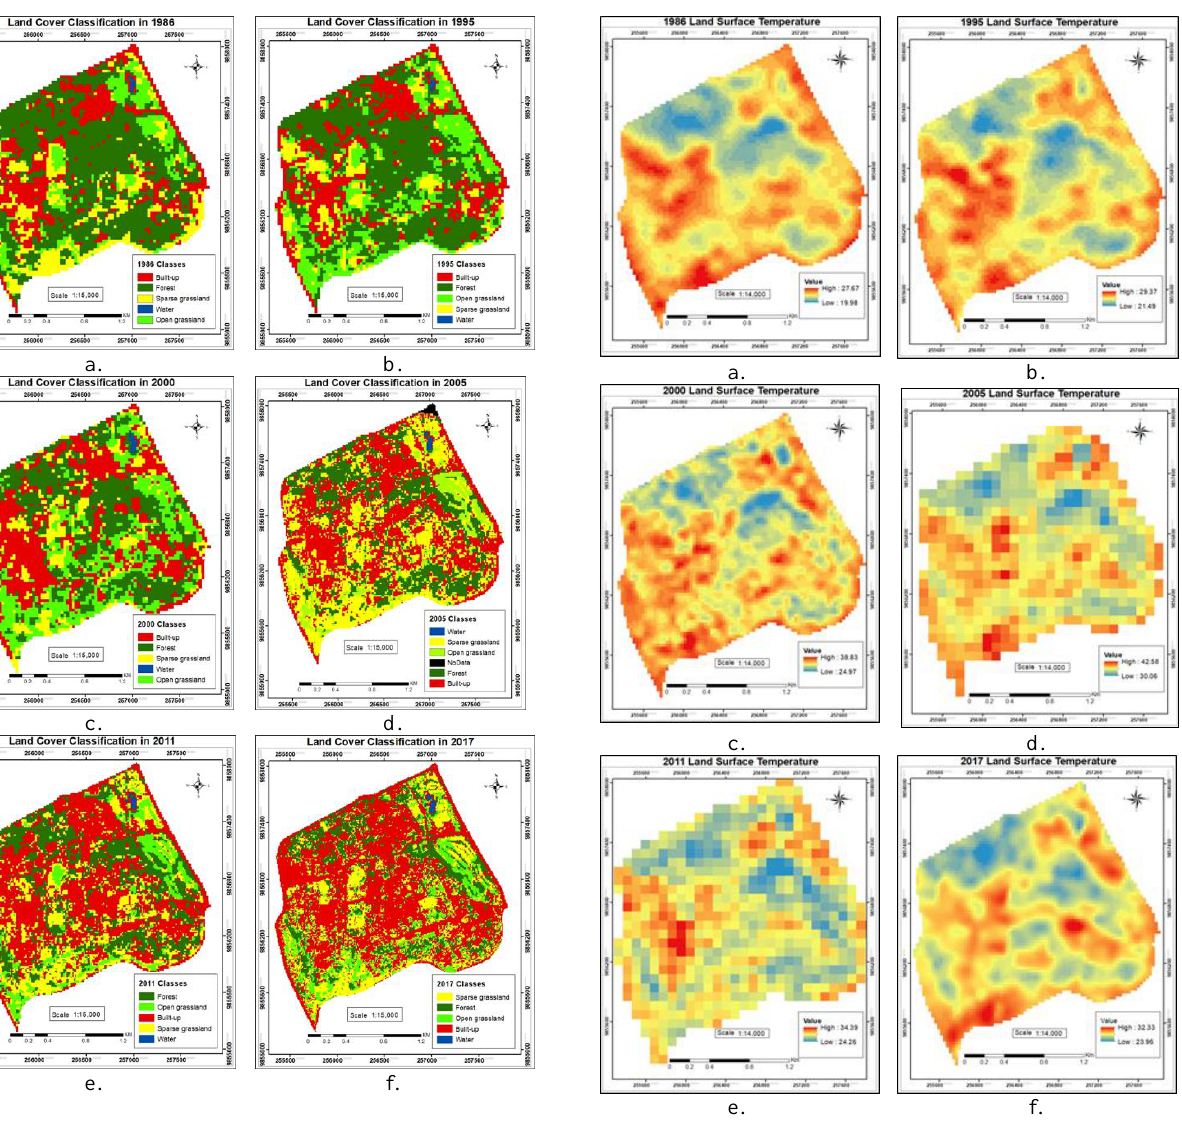
Figure 4: Land cover classification for 1986(a), 1995(b), 2000(c), 2005(d), 2011(e) and 2017(f), in Upper Hill, Nairobi This was attributed to dry conditions in each of these years, with 2010 to 2011 drought being the worst drought in 60 years (Mbogo et al ., 2015). 1986 had lower mean LST which indicated increased mean LST thus changing climatic conditions (Table 4). Table 4: Minimum, maximum and mean LST from 1986 to 2017 In all years analyzed (Figure 6), sparse grassland had higher LST compared to other land cover with 25.5 0 C in 1986 (figure 6a) and 35.7 0 C in 2005 (figure 6d).